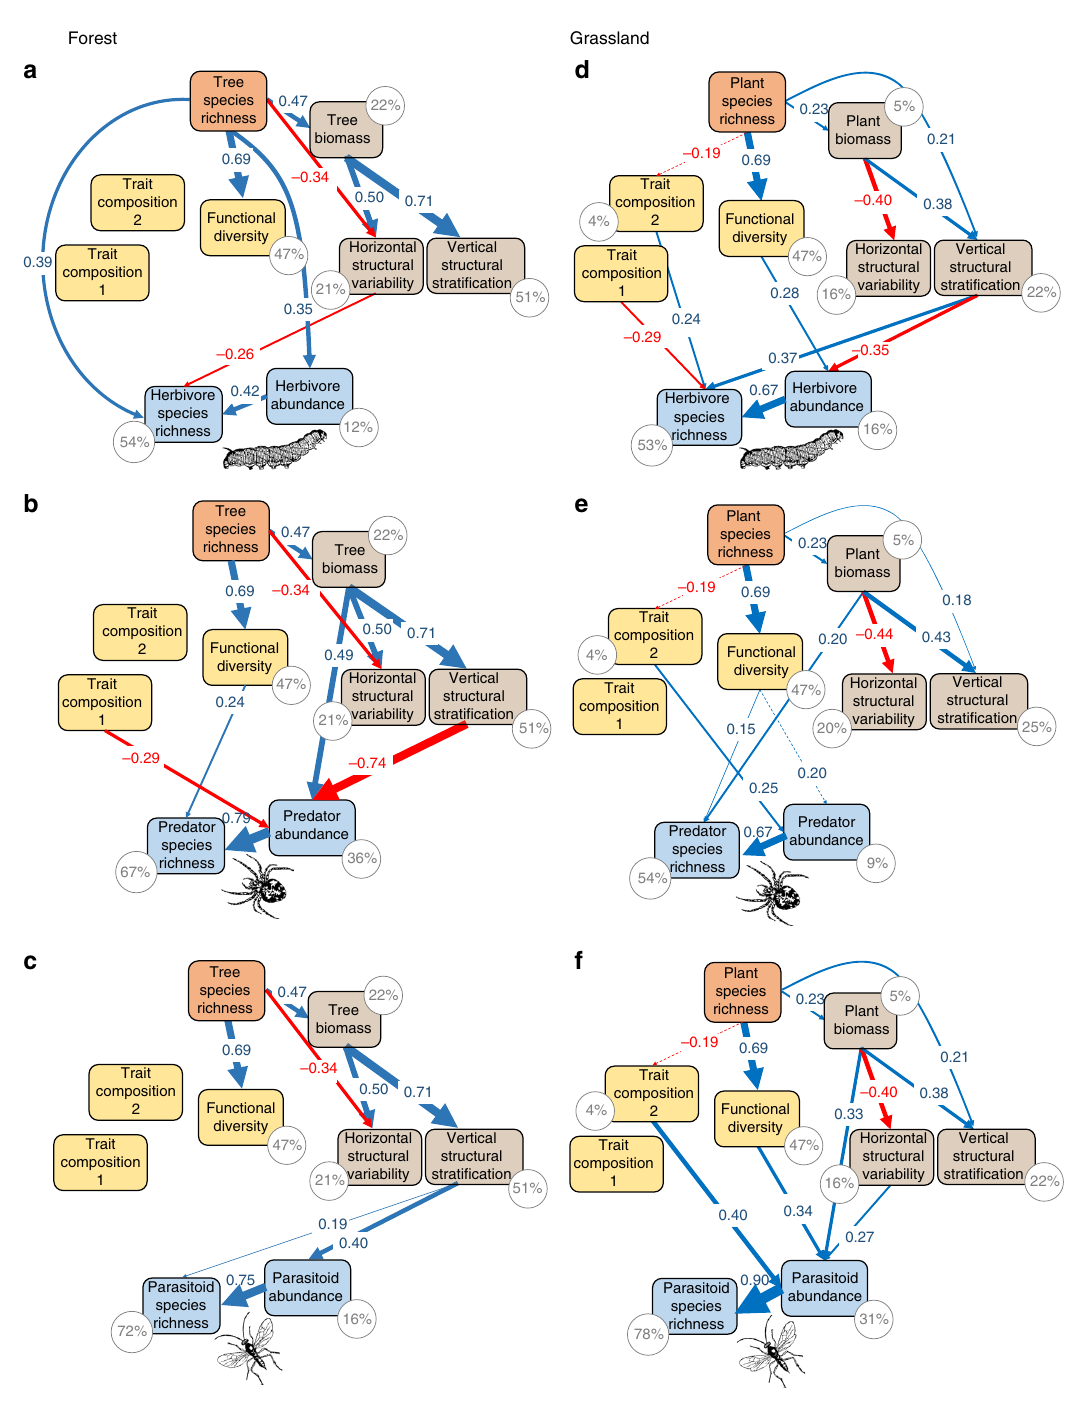
Fig. 2 Effects of plant diversity on arthropods across trophic levels. Direct and indirect effects of plant species richness (orange), leaf trait functional diversity and composition (yellow), and structural characteristics (brown) of the forest and grassland plant communities on arthropod abundance and species richness (blue) based on path model results. a Forest herbivores ( χ 2 = 6.6, DF = 11, P = 0.796), b forest predators ( χ 2 = 13.4, DF = 17, P = 0.723), c forest parasitoids ( χ 2 = 7.7, DF = 12, P = 0.814), d grassland herbivores ( χ 2 = 25.3, DF = 20, P = 0.259), e grassland predators ( χ 2 = 14.8, DF = 15, P = 0.495), f grassland parasitoids ( χ 2 = 27.2, DF = 21, P = 0.302). Trait compositions 1 and 2 represent the fi rst two axes of a principal components analysis (PCA) on community-weighted means of fi ve leaf traits; functional diversity is the mean pairwise dissimilarity (based on Rao ’ s Q ) of these traits among study plots. Vertical strati fi cation (based on Rao ’ s Q ) and horizontal variability of plant structure (based on Moran ’ s I ) represent variability in plant height (grassland) or the fi rst two axes of a PCA on the variability of tree height and crown projection area (forest) within the study plots. Positive and negative pathways and their corresponding standardized path coef fi cients in c and d are indicated in blue and red, respectively. Solid lines show signi fi cant relationships ( P ≤ 0.05 based on 1000 bootstrap draws; scaled by their standardized effects), dotted lines show non-signi fi cant pathways (see Supplementary Tables 4 – 9 for full results). For clarity, covariances between structural and functional diversity (see Fig. S4) were not plotted but are shown in Supplementary Tables 4 – 9. Percentage values show the explained variance of endogenous (dependent) variables. The animal icons (from